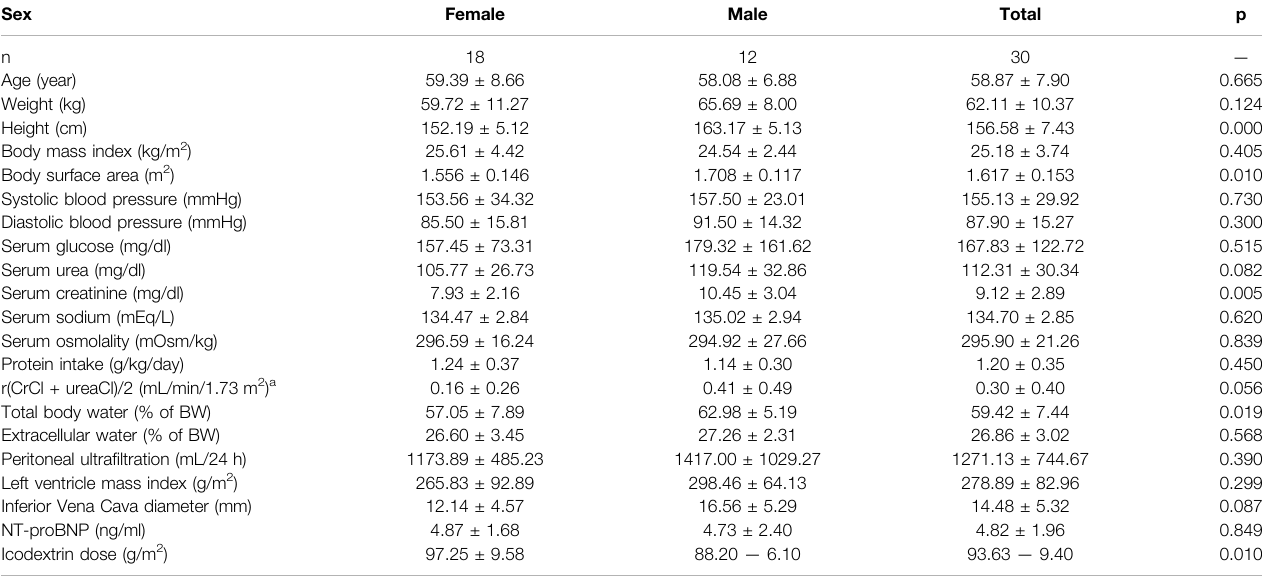
TABLE 2 | Cardiovascular vaiables by sex at baseline.